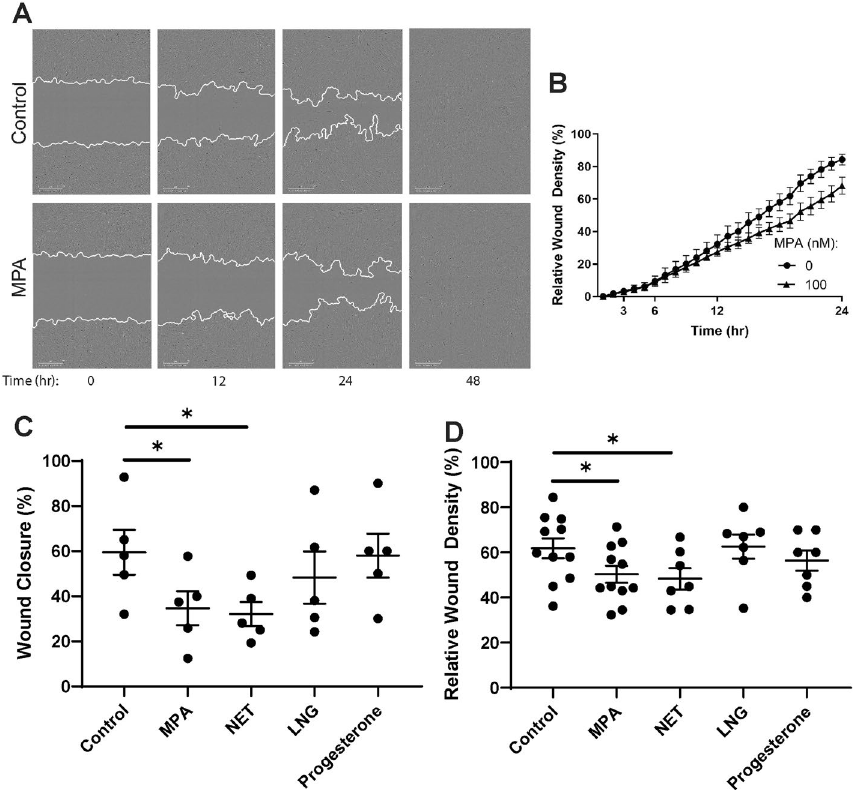
Figure 3. MPA and NET inhibit wound closure by endometrial stromal fibroblasts. (A) Representative images of endometrial stromal fibroblasts grown in 96-well plates scratched using an IncuCyte WoundMaker in the absence (control) or presence of MPA (100 nM) at 0, 12, 24, and 48 h at × 10 magnification using the IncuCyte Zoom. Time of scratch is 0 h. The solid white line represents the fibroblast wound front. (B) Relative wound density of endometrial stromal fibroblasts grown in 96-well plates 24 h post-scratch in the presence (100 nM) or absence of MPA. Data shown is from a representative patient. Each symbol represents the mean + /− SEM from a single timepoint. (C) Wound closure of endometrial stromal fibroblasts grown in 24-well plates at 24 h post-scratch following treatment with 100 nM MPA, NET, LNG, or Progesterone for 48 h prior to scratch. MPA, NET, LNG, and Progesterone were maintained in cell culture media at 100 nM following scratch. Each symbol represents a single individual ( n = 5 ). ( D ) Relative wound density of endometrial stromal fibroblasts